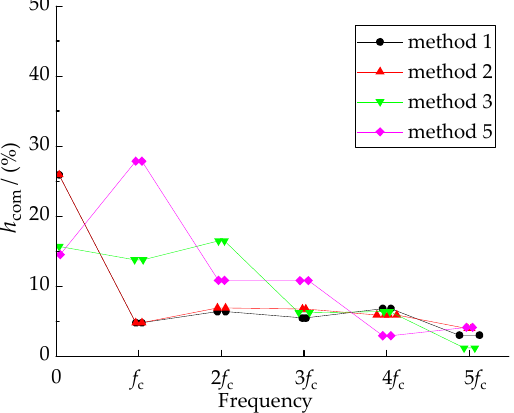
Figure 15. Maximum peak values of common-mode components at different frequency bands.